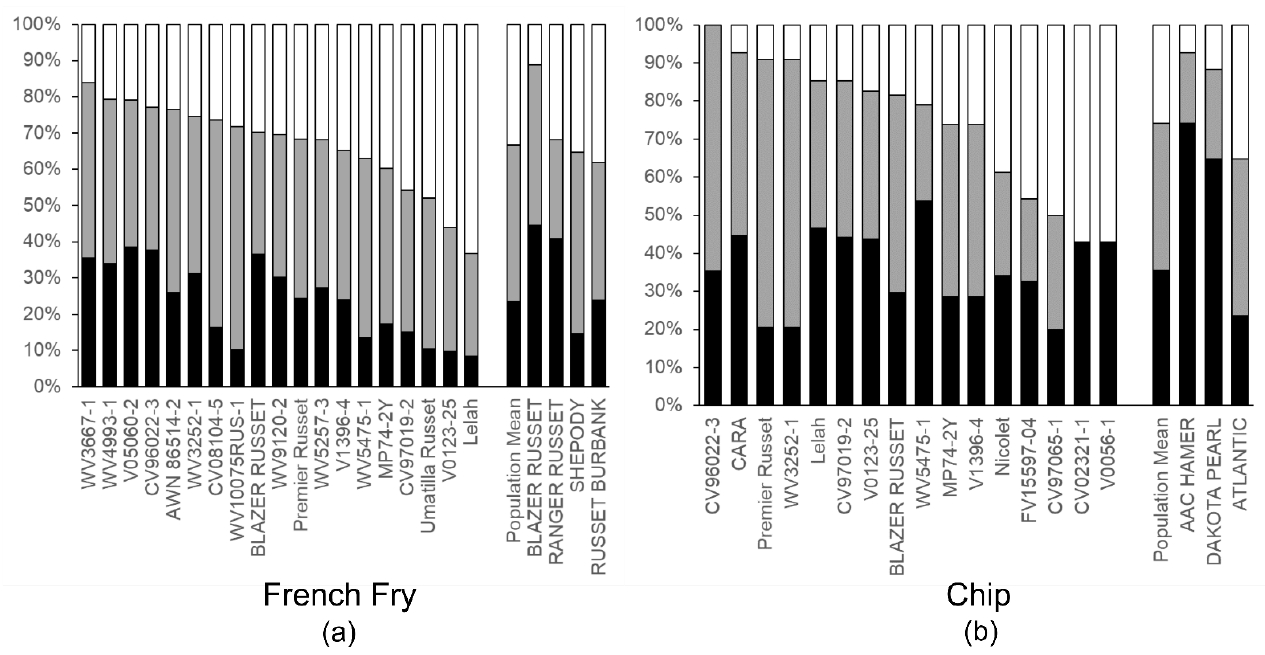
Figure 6. Proportion of Excellent (black), Acceptable (grey) and Not Acceptable (white) tubers derived from parents in the crossing population. ( a ) French fry market class. ( b ) Chip market class.